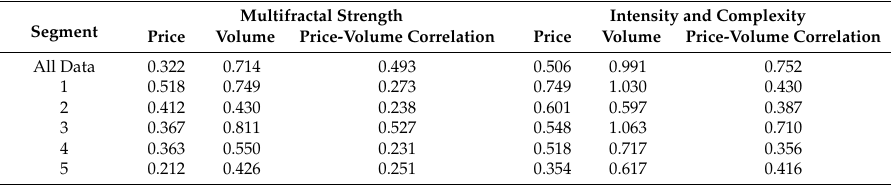
Table 4. Strength and complexity across structural